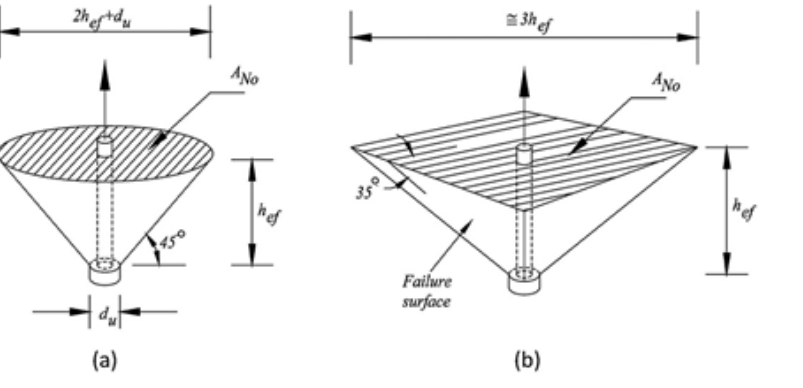
Figure 3: Base material failure models according to: a) ACI 349-85 (conical failure) and b) CCD (four-sided pyramid failure) [2, 9, 22, 23] CCD, concrete capacity